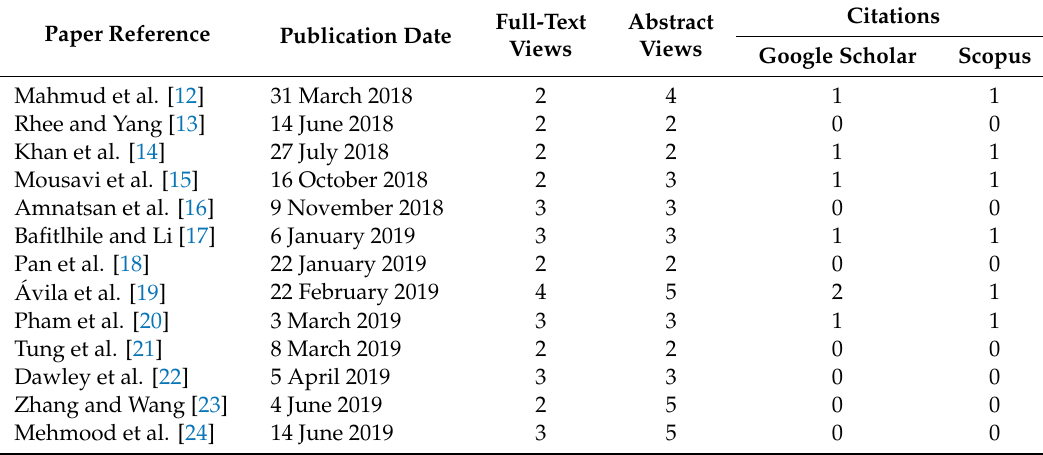
Table 1. Metrics of the papers published in this Special Issue (average full-text and abstract views per day were calculated until 30 August